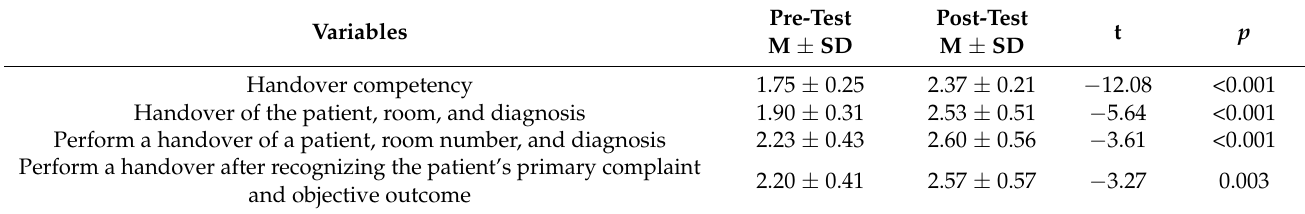
Table 3. Comparison of handover performance competency before and after the education program ( N =